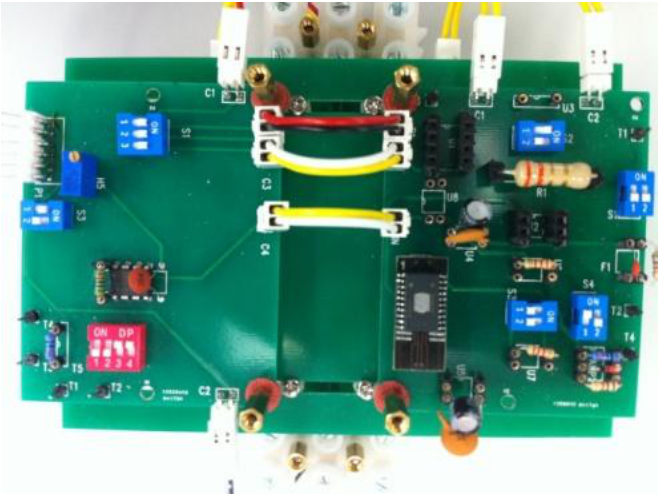
Figure 6. Photo of the prototype current